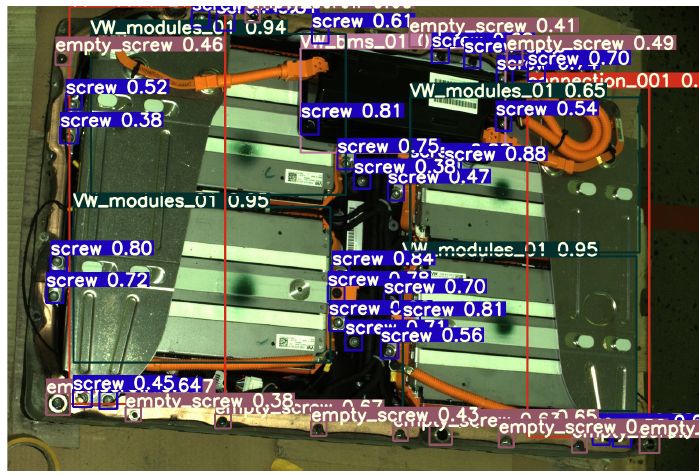
Figure 9. YOLOv3 output results: all screws, modules, transverse covers, and BMS are detected, classified, and localised. 242